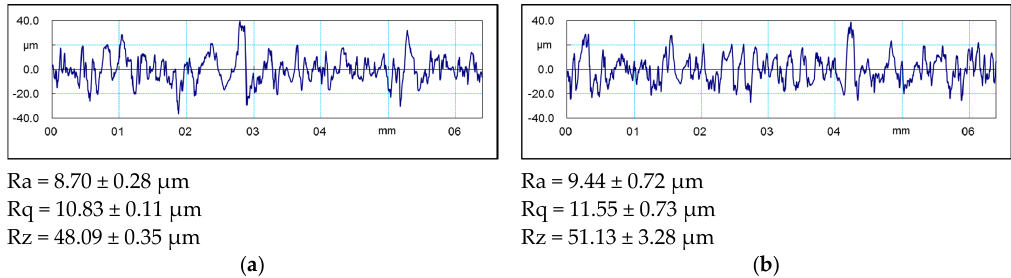
Figure 12. Roughness evaluation profiles and roughness of wire arc copper coating surfaces: ( a ) conventionally coated in air; ( b ) coated in silane ‐ doped nitrogen.